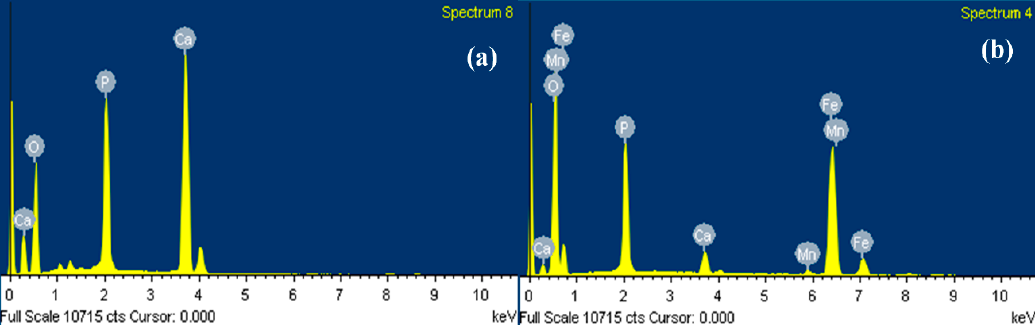
Figure 3. EDX spectra of ( a ) HAP and ( b ) HAP-MnFe 2 O 4 nanocomposite.